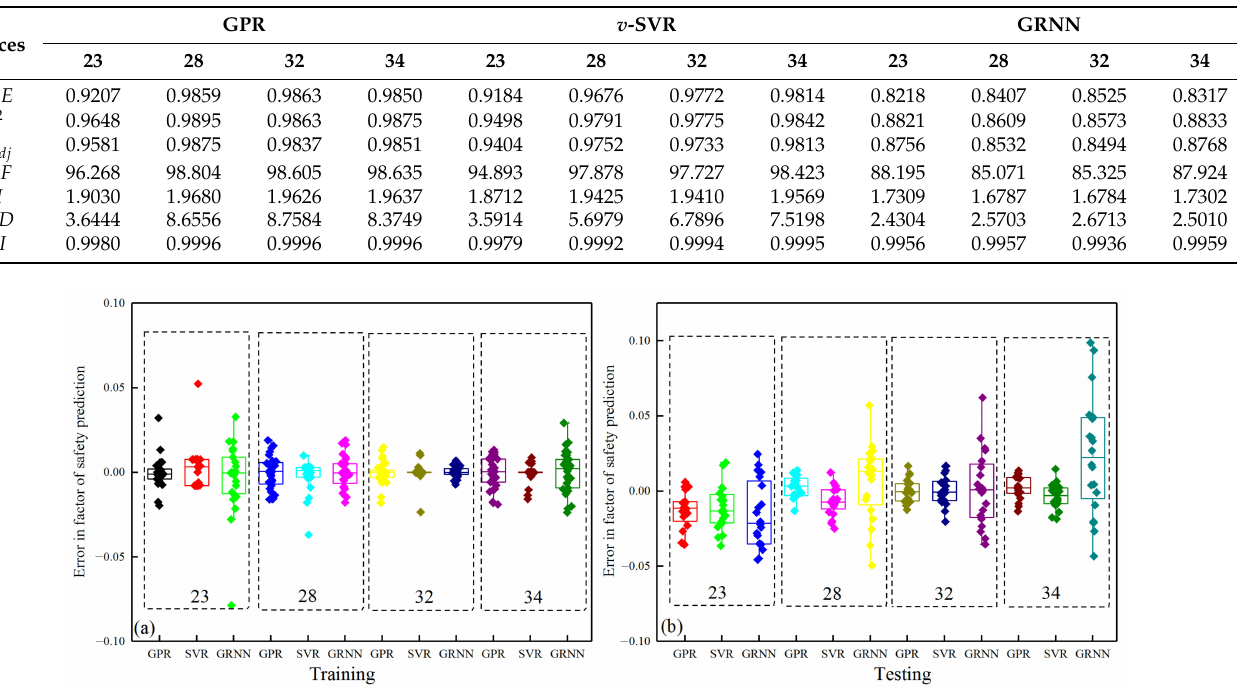
Figure 13. Case 2: Errors of factors of safety obtained from GPR, v -SVR, and GRNN methods by employing ( a ) training points and ( b ) testing